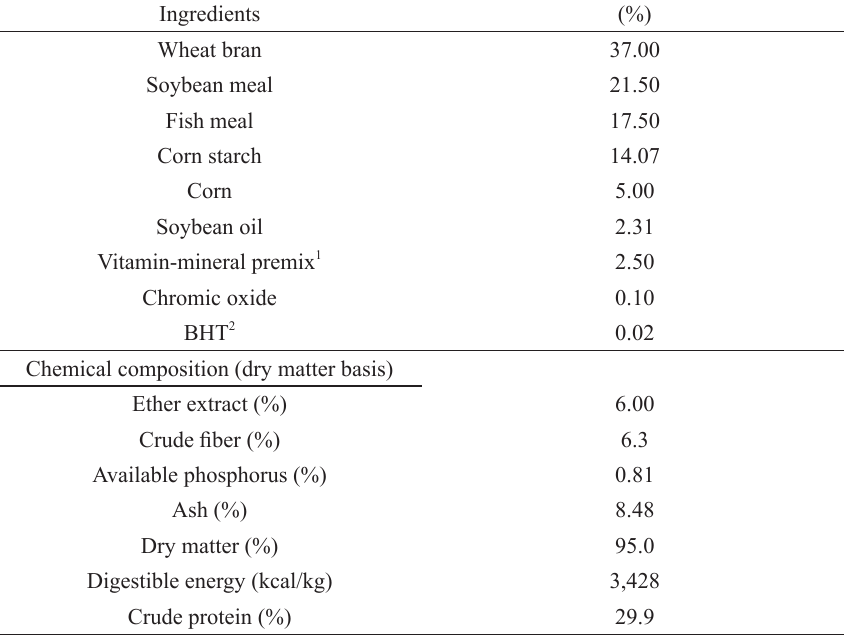
Ingredients and chemical composition of reference